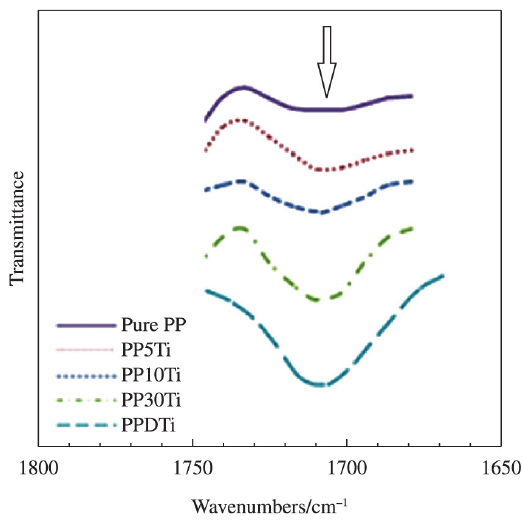
Figure 3. FTIR spectra of the pure PP films and PP nano-composite films after 500 hours of UV